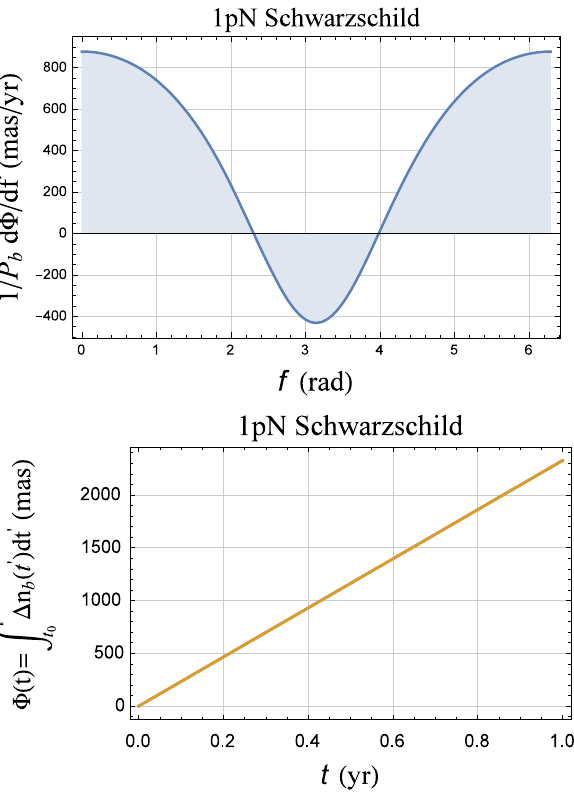
Fig. 1 Upper panel: plot of Eq. (27), computed for the orbital con- figuration of Table1 and with f 0 = 228 ◦ , over a full orbital cycle of the true anomaly f . Its area, giving Eq. (26) in mas year − 1 , amounts to 2 , 326 . 6masyear − 1 . Lower panel: numerically produced time series, in mas,of (cid:8)( t ) over1yearobtainedbyintegratingtheequationsofmotion in rectangular Cartesian coordinates for the fictitious Earth’s satellite of Table1. The 1pN gravitoelectric Schwarschild-like acceleration was added to the Newtonian monopole. As initialvalue for the true anomaly, f 0 = 228 ◦ was adopted. The slope of the linear trend amounts just to the area under the curve in the upper